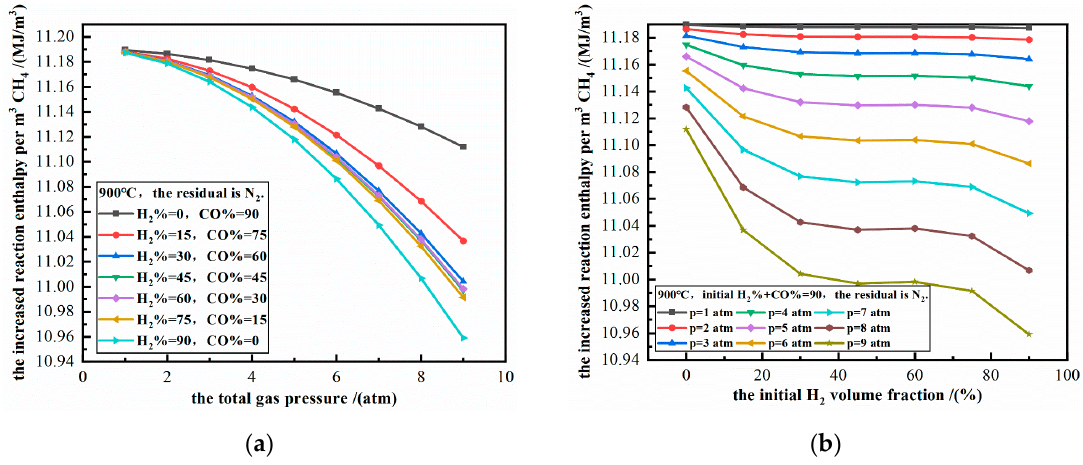
Figure 10. The increased reaction enthalpy per m 3 CH 4 at 900 with H 2 % + CO% = 90. ( a ) the x -axis is the total gas pressure; ( b ) x -axis is the initial H 2 volume fraction.